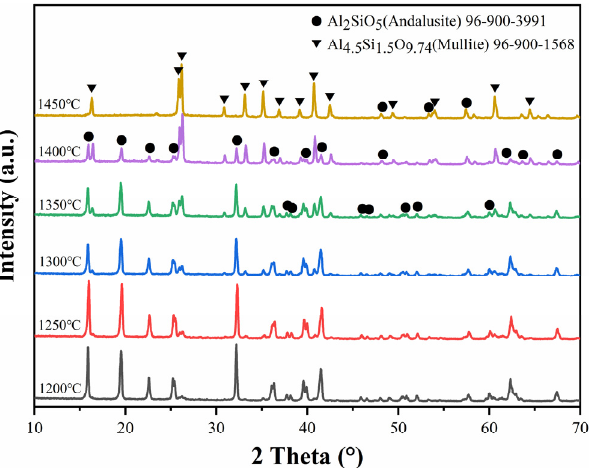
Figure 4. XRD patterns of micronized andalusite ( ≤ 5 μ m) after firing in the temperature range of 1200 °C to 1450 °C for 3 h.